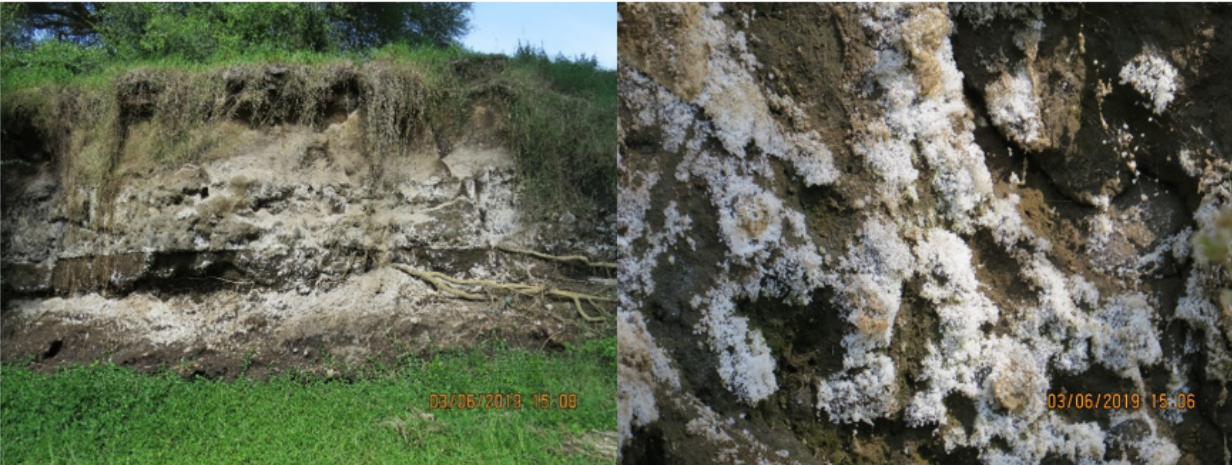
Figure 8. Pictures showing evaporitic salt “magadi” on the soil surface at Ngarenanyuki on the northeastern flank.